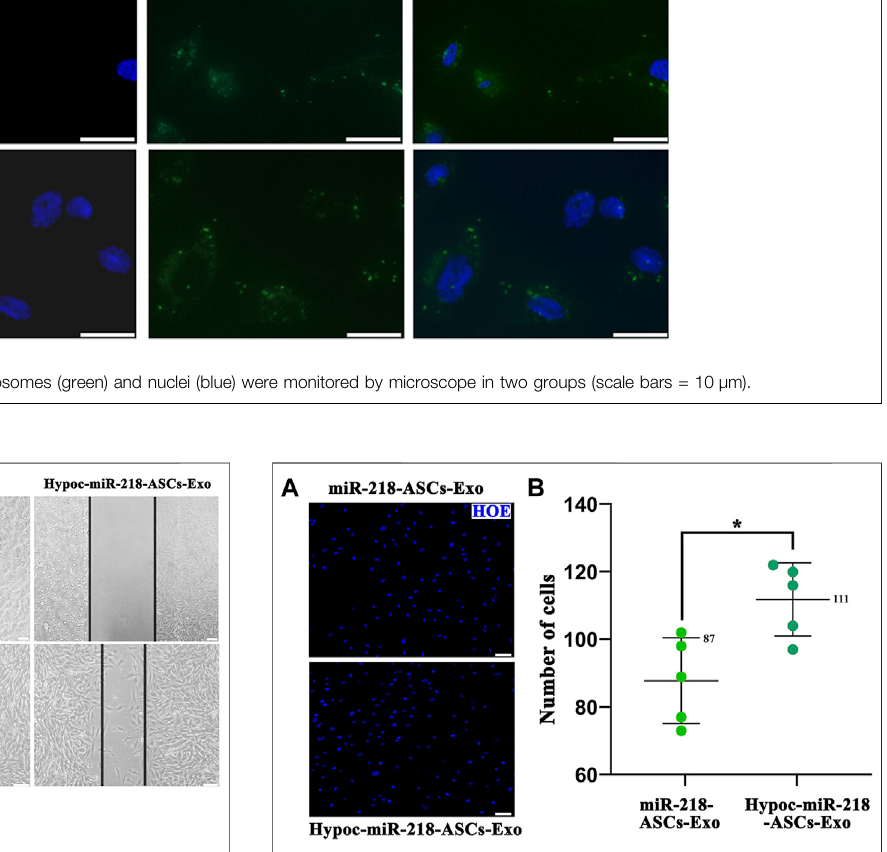
FIGURE 8 | Transwell assay. (A) Nuclei of the cell across the membrane werestainedbyHoechst33342(blue)(scalebars=50 μ m). (B) Cellnumberin a view fi eld was counted, respectively, in two